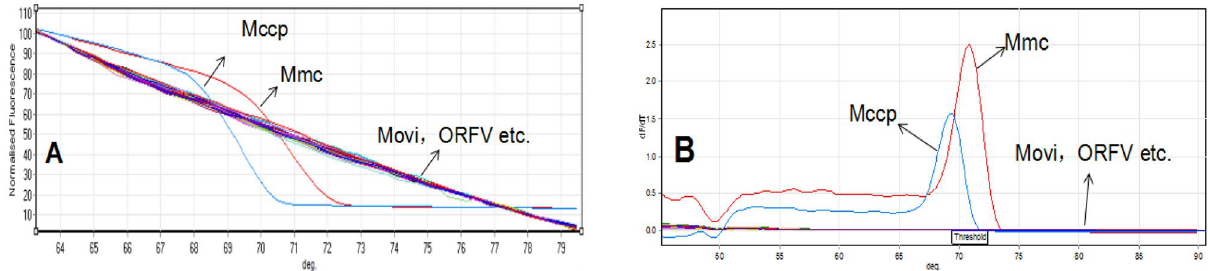
Figure 2. Specificity test of the HRM method for Mccp and Mmc. The pictures are generated by Rotor Gene Q. ( A ) Normalized characteristic curves of sample; ( B ) Melting curve of sample.